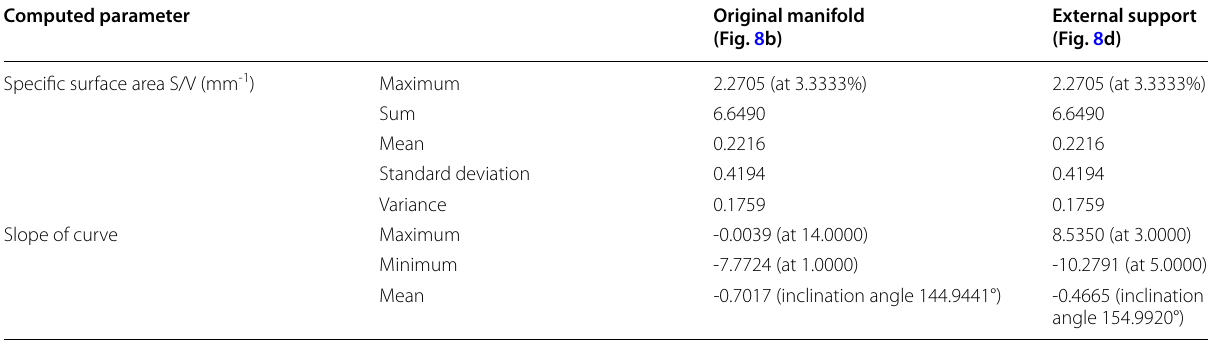
External support (Fig. 8d)